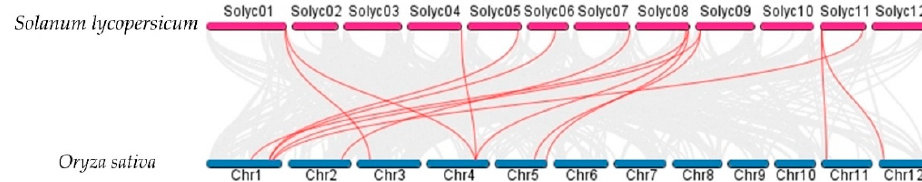
Figure 8. Syntenic analysis between AAt regions of Solanum lycopersicum and Oryza sativa . Gray lines in the background indicate collinear blocks between Solanum lycopersicum and Oryza sativa , while red lines highlight syntenic AAT gene pairs.